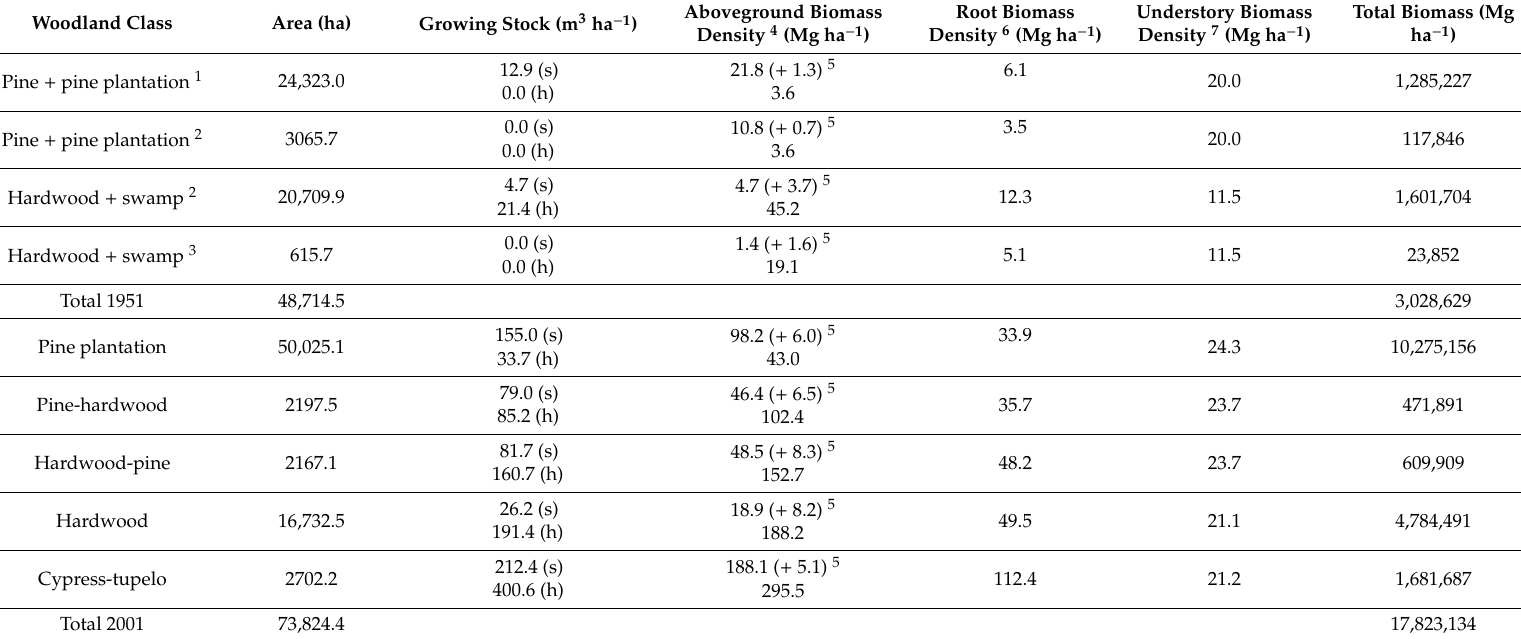
Table 3. Forest vegetation biomass density and total biomass estimates for softwoods (s) and hardwoods (h) for 1951 and 2001 using Method B [34], forest land area (Table 1) and forest understory values form (Supplemental Table S3) and for 2001